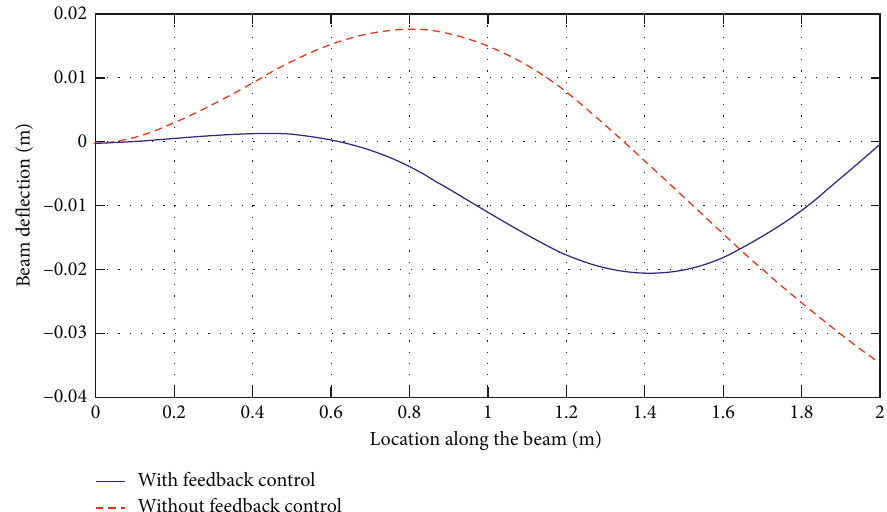
Figure 11: The steady-state deformed shape of a collocated controlled (solid line) and uncontrolled (dashed line) undamped cantilever beam when ω � 30.984, x f � 1, x n � 1, and x a � 0.375.